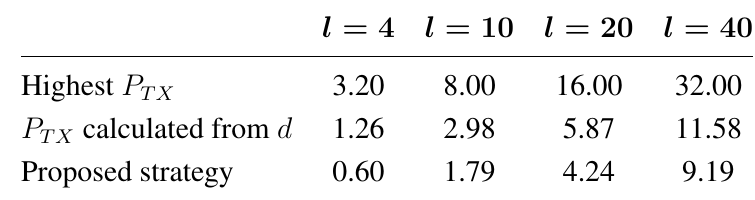
Table 2. Average energy consumption (in µ J) of the three strategies for different packet